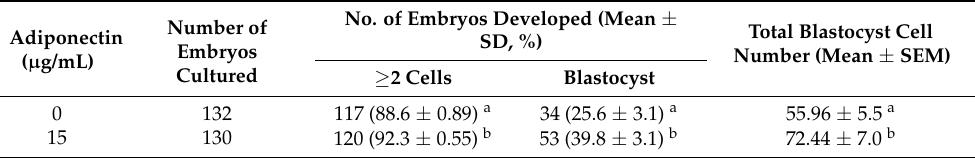
Figure 1. Effect of adiponectin supplementation of various concentrations during in vitro culture of parthenogenetic activation embryos on cleavage rate ( a ), blastocyst formation rate ( b ), total cell numbers ( c ), and protein expression of XBP1 ( d ); Hoechst staining of blastocysts (Scale bars 50 µ m) ( e ) and XBP1 immunofluorescence (scale bars 50 µ m) ( f ). Data are expressed as mean ± SD. a,b Bars with different letters indicate significant difference ( p < 0.05). The experiment was performed as at least three independent replicates. AdipoQ 5 = adiponectin 5 µ g/mL; AdipoQ 15 = adiponectin 15 µ g/mL; AdipoQ 30 = adiponectin 30 µ g/mL. TCN, total cell number of blastocysts. Table 2. Effect of adiponectin treatment during in vitro culture (IVC) on embryonic development and total blastocyst cell number derived from somatic cell nuclear transfer (SCNT)